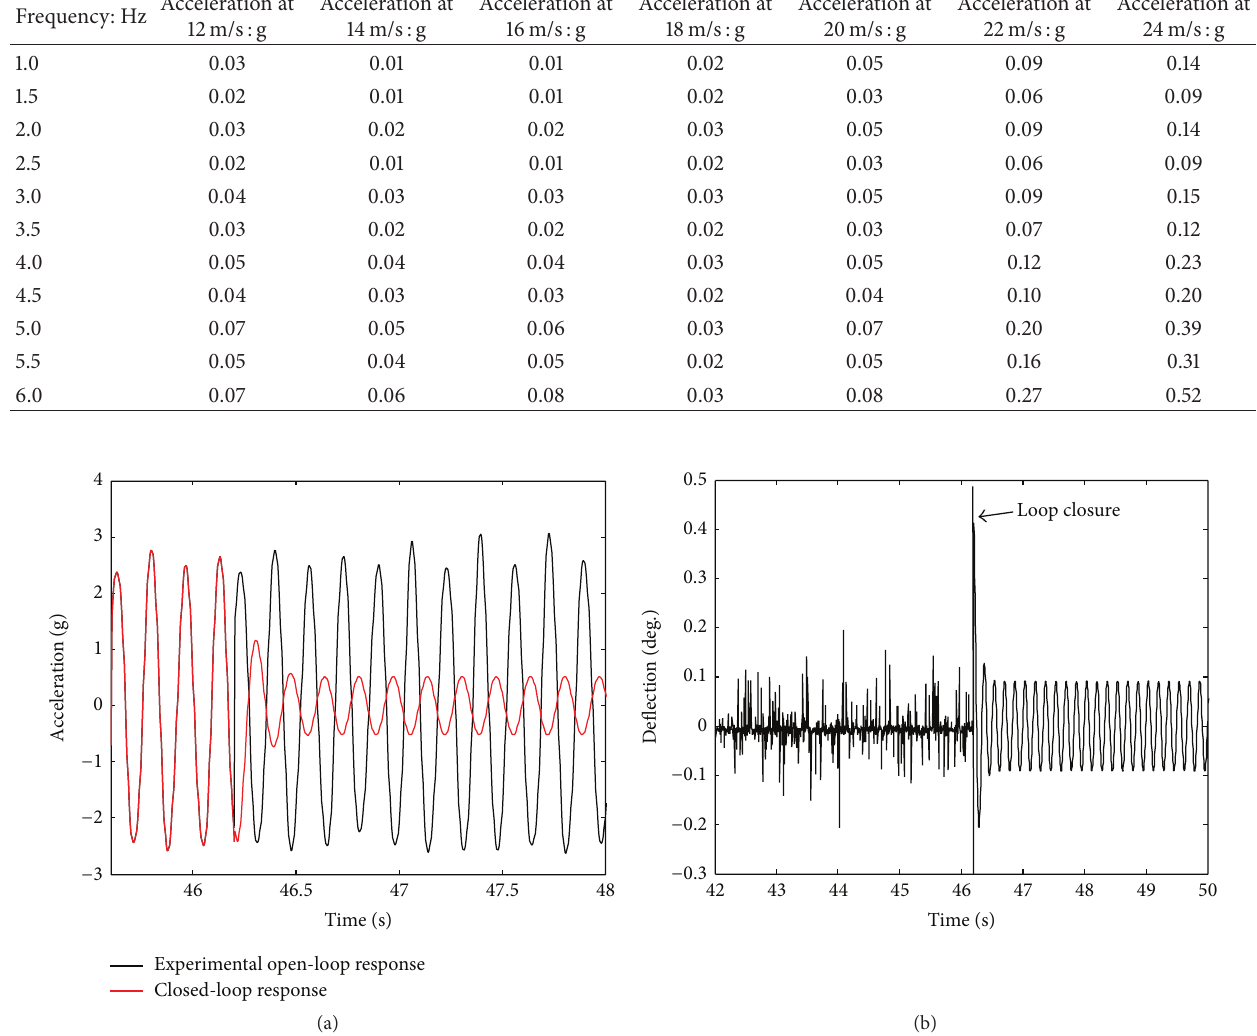
Figure 8: The closed-loop response (a) and the deflection of aileron